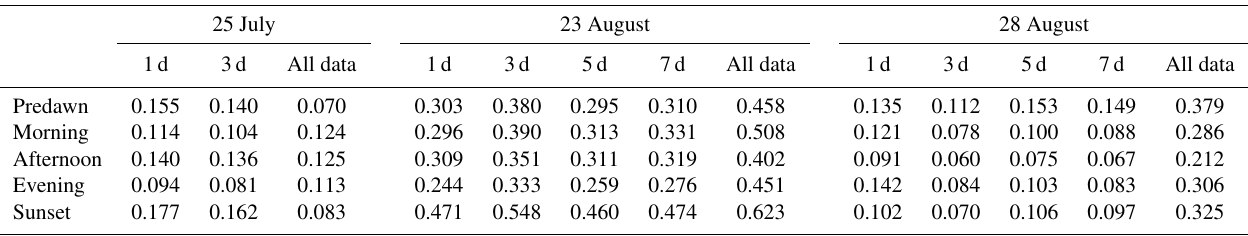
Table A2. Root mean squared error (RMSE) between reconstructed and sampled VWC. The rows represent time of constraining the recon- struction, while the columns represent the considered period for CDF matching.